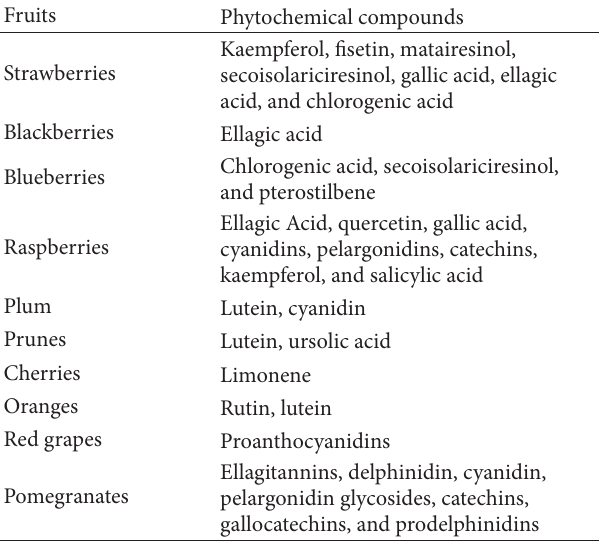
Table 1: Various phytoconstituents present in fruits.